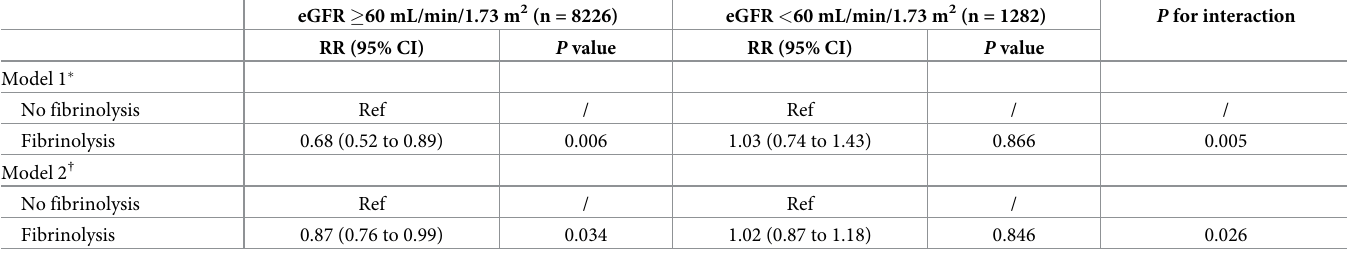
Table 2. Associations between fibrinolytic therapy and the risk of short-term major adverse cardiovascular events among patients with and without reduced kidney function (eGFR < 60 mL/min/1.73 m 2